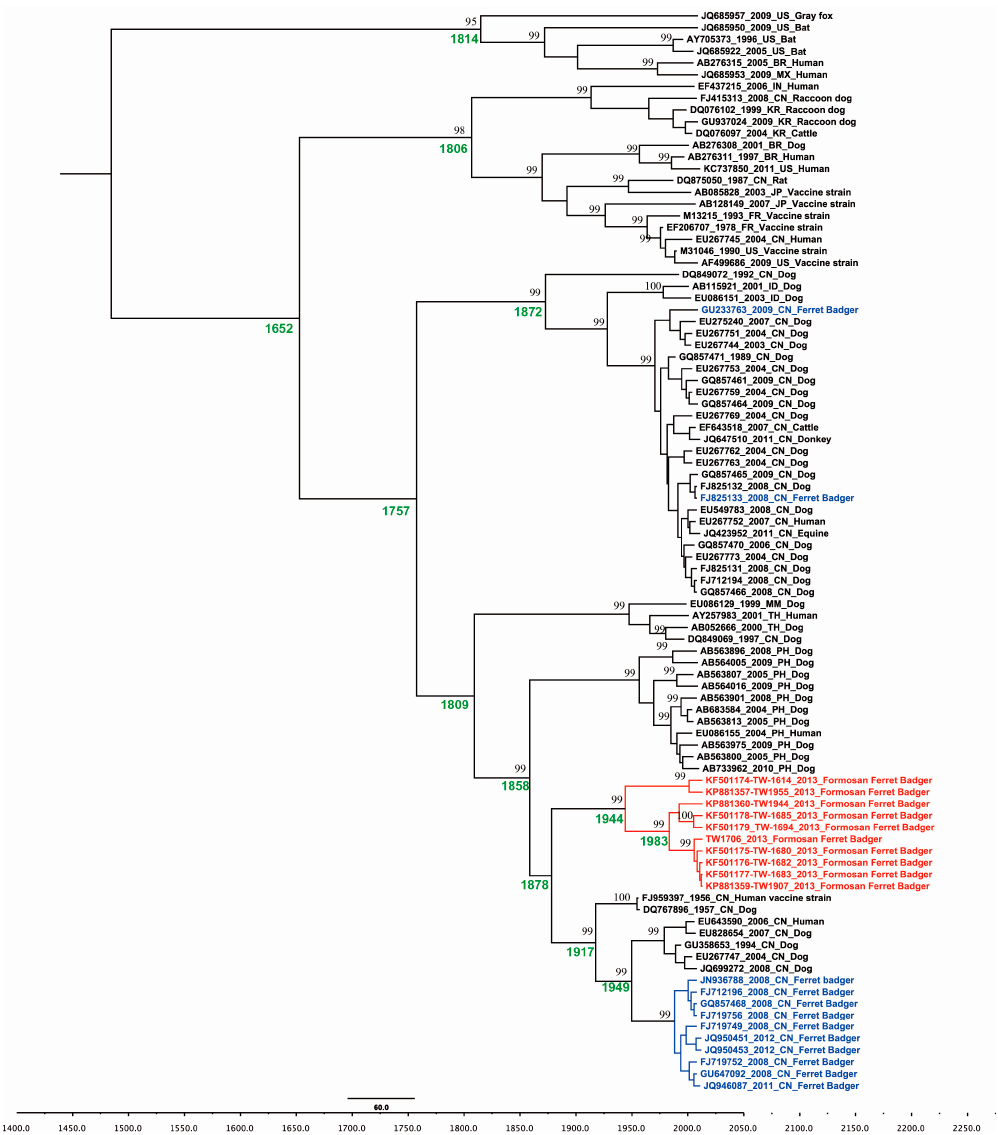
Figure 3. The Maximum Clade Credibility (MCC) tree of the rabies virus based on glycolprotein. The MCC tree was constructed with 10% burn-in by Tree Annotator v 1.8 implemented in the BEAST software package. Numbers beside the branches are posterior probability and branching time (Text in green). Only posterior probability values above 0.95 are shown. Texts in red and blue represent the RABV isolated from Formosan and Chinese ferret badgers, respectively.